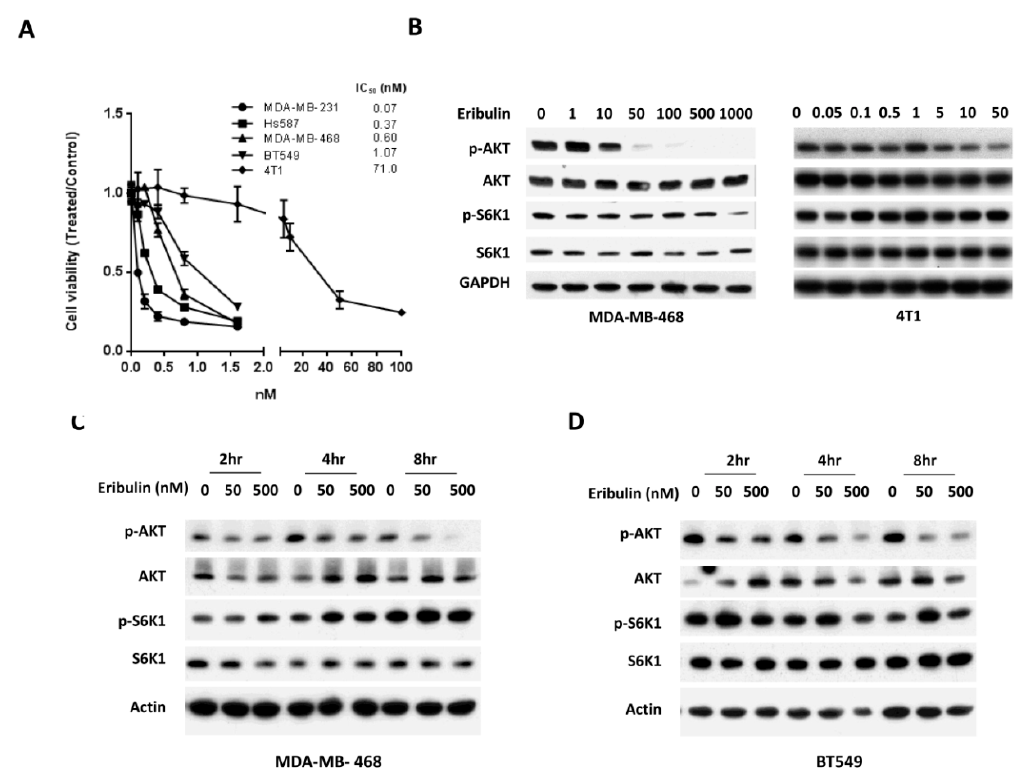
Figure 1. Eribulin inhibits cell viability and AKT phosphorylation in triple negative breast cancer (TNBC) cells. ( A ) TNBC cells were treated with various concentrations of eribulin. Cell viability was determined 72 h later. The IC 50 was determined by the Chou-Talalay method. ( B ) Cells were treated with eribulin at concentrations of 1–1000 nM for MDA-MB-468 and 0.05–50 µ M for 4T1 cells. Cells blot analysis. ( C – D ) MDA-MB-468 and BT549 cells were treated with eribulin for the indicated